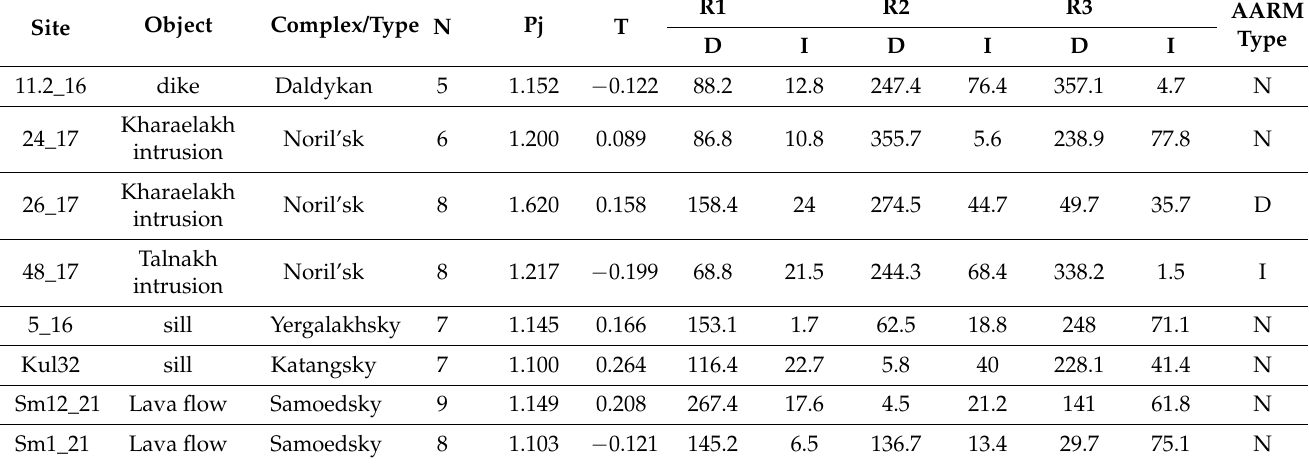
Table 1. Results of anisotropy of anhysteretic remanent magnetization measurements. N—number of samples, Pj—corrected degree of anisotropy, T—parameter of ellipsoid shape; R1, R2,